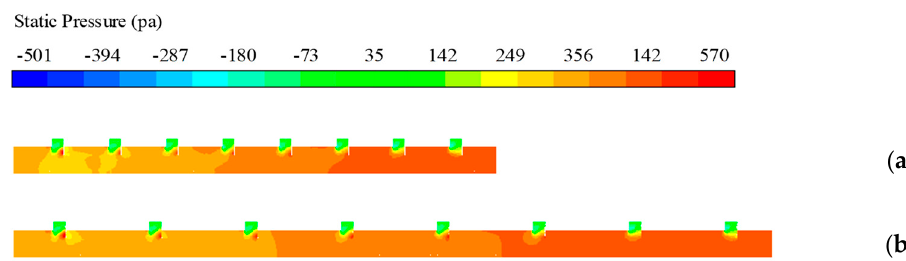
Figure 7. Contours of static pressure on the central plane of the gas-filled line with the branch pipes spaced different distances apart. ( a ) Distance between adjacent branches: 120 mm; ( b ) Distance between adjacent branches: 200 mm.